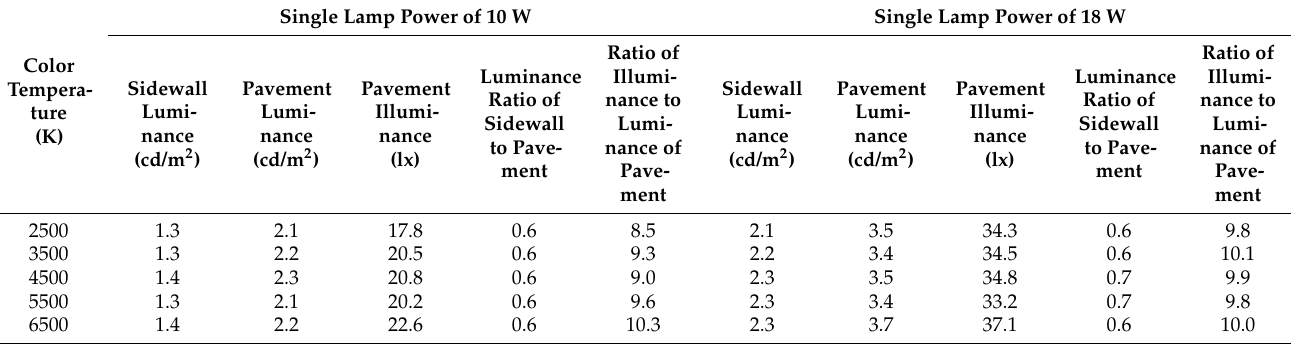
Table 2. Luminance and illuminance in tunnel decorated with gray